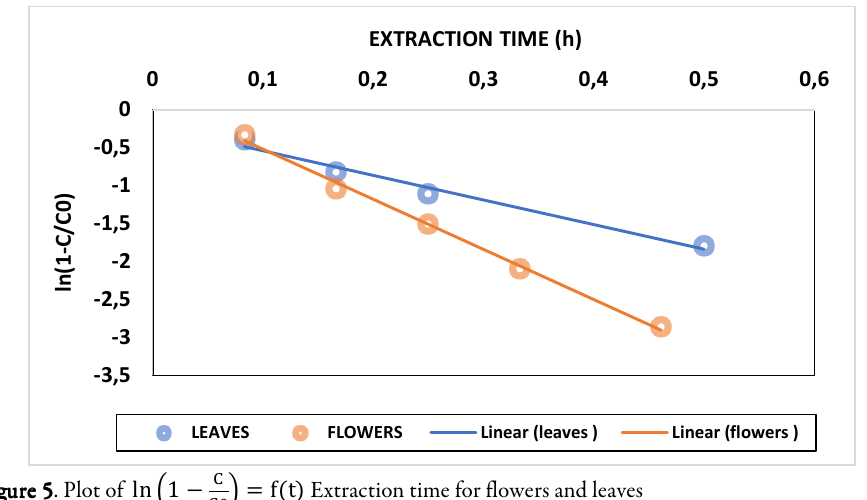
(cid:25) (cid:2) f(cid:15)t(cid:18) Extraction time for flowers and leaves (cid:11)(cid:24)